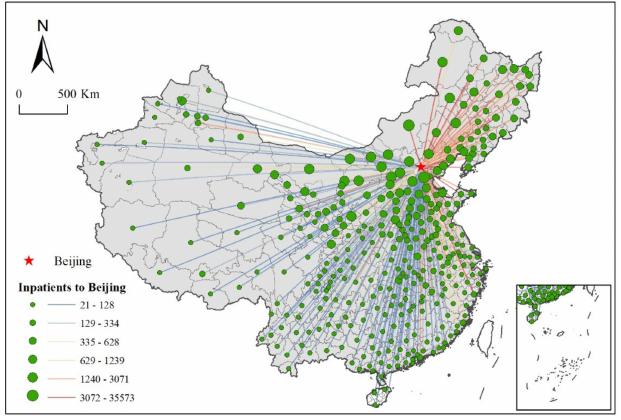
Figure 8. The flow of patients from city-level regions to